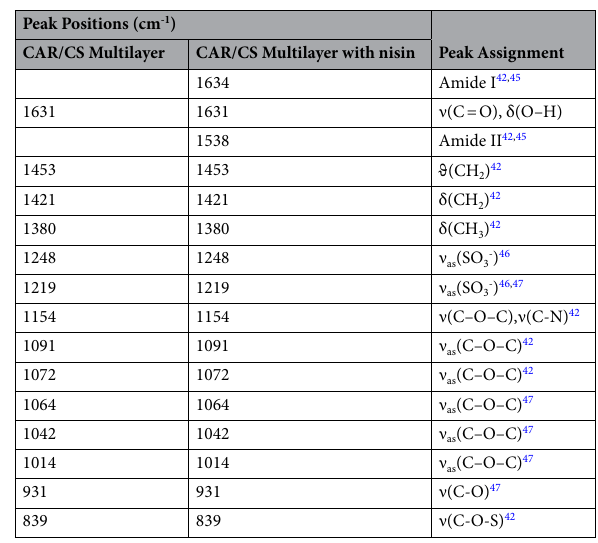
Table 1. Peak positions and assignments for (i) ATR FTIR spectrum of a 4.5-bilayer CAR/CS PEM; and (ii) ATR FTIR spectrum of a 4.5-bilayer CAR/CS PEM containing nisin Z. a Peaks dominated by acetic acid used to dissolve chitosan b Most likely from uronic acid present in the carrageenan; Annotations: ν—stretching vibrations, ν s —symmetric stretching vibrations, ν as —asymmetric stretching vibrations, δ—in-plane bending vibrations, —bending ϑ